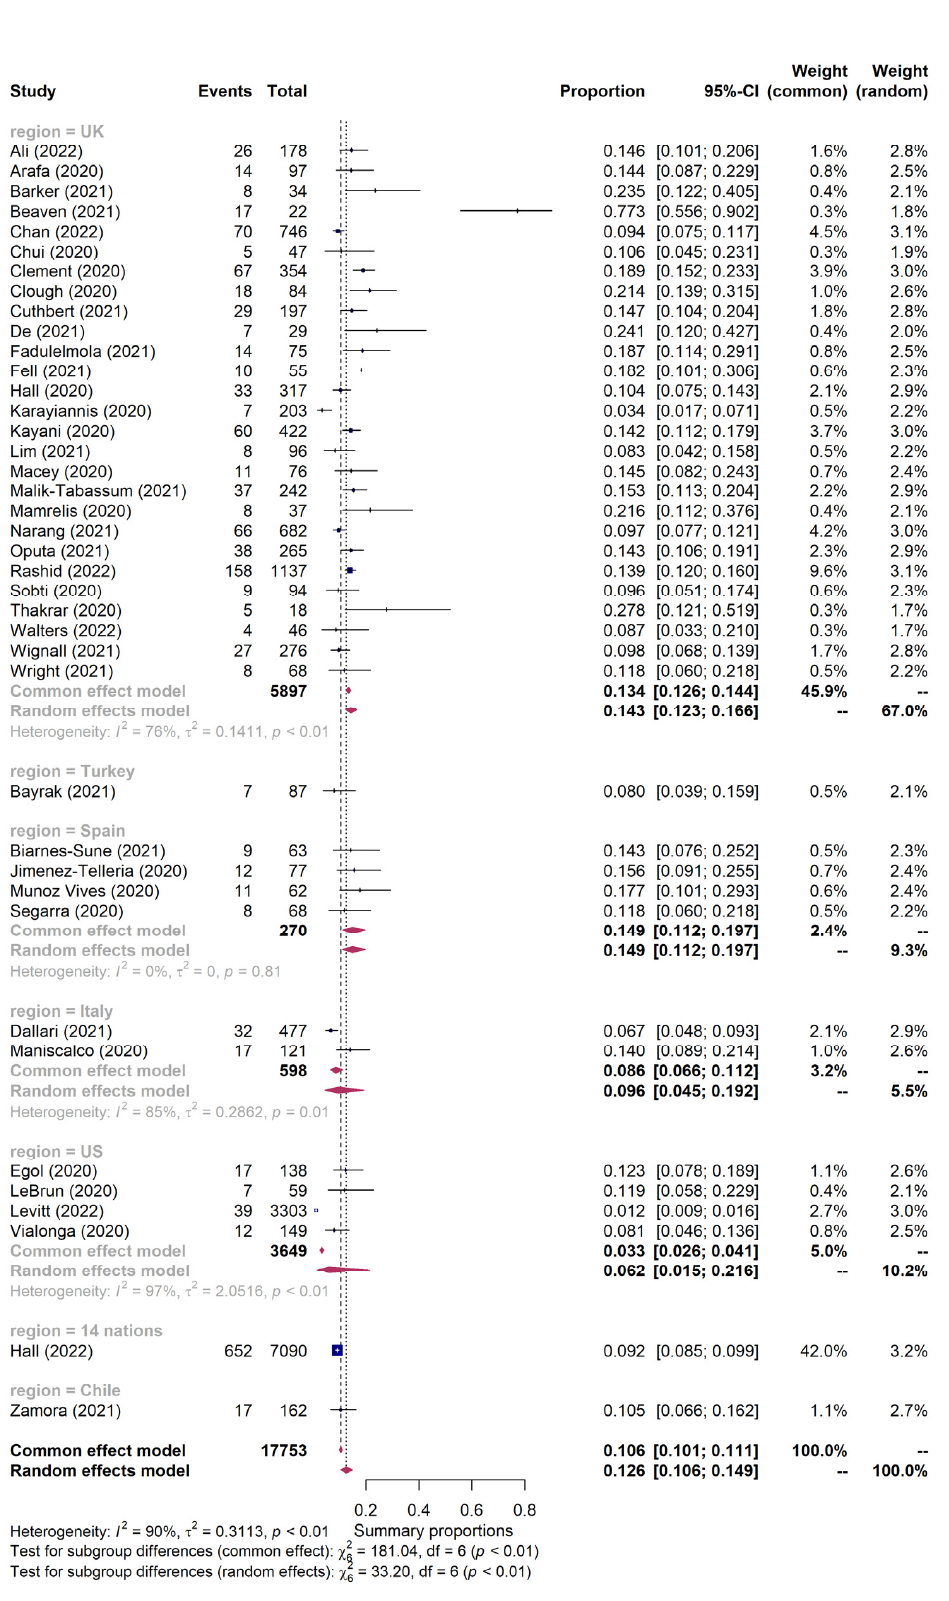
Figure 2. Forest plot for 30-day mortality of patients with hip fractures during the COVID-19 pan- demic according to the study region